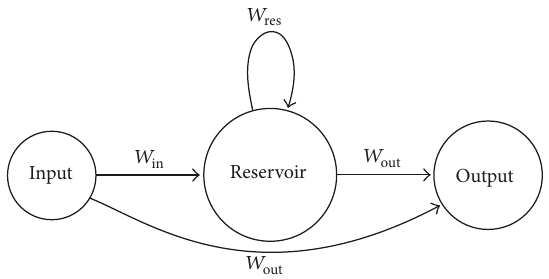
Figure 1: Echo State Network (ESN) architecture. Image by